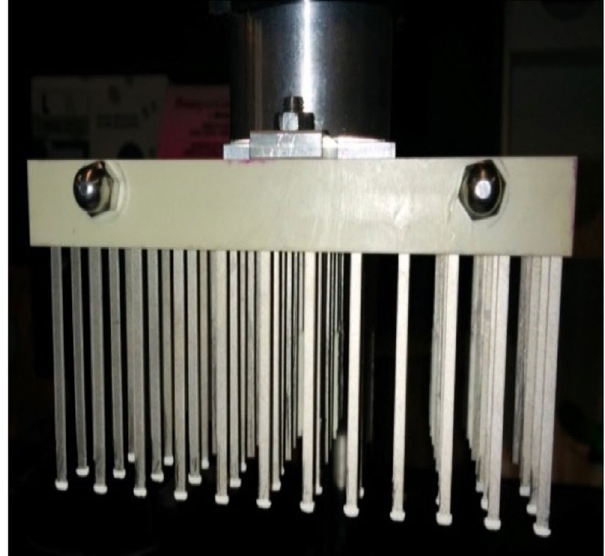
Figure 1. HLB TF-SPME blades with 1 mm coating